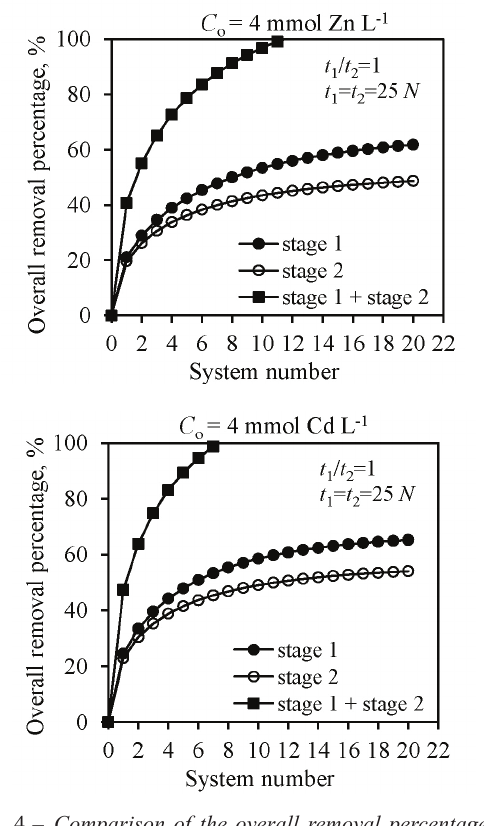
Fig. 5 – Comparison of the overall removal percentage and removal percentages in stages 1 and 2 in relation to system number for 2 mmol L –1 Zn and